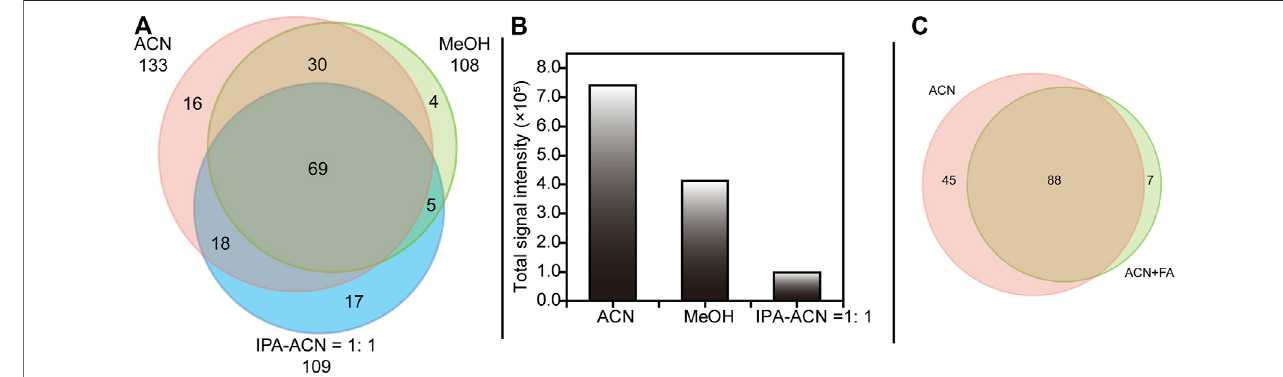
FIGURE 3 | Venn diagram (A) shown the selectivity of PLs among ACN, MeOH and IPA-ACN (cid:2) 1:1 and (C) shown the in fl uence of addictive during DESI-MS analysis. Bar chart (B) showing the overall peak intensities of the putatively identi fi ed PLs. Abbreviations: MeOH, methanol; ACN, acetonitrile; IPA-ACN (cid:2)